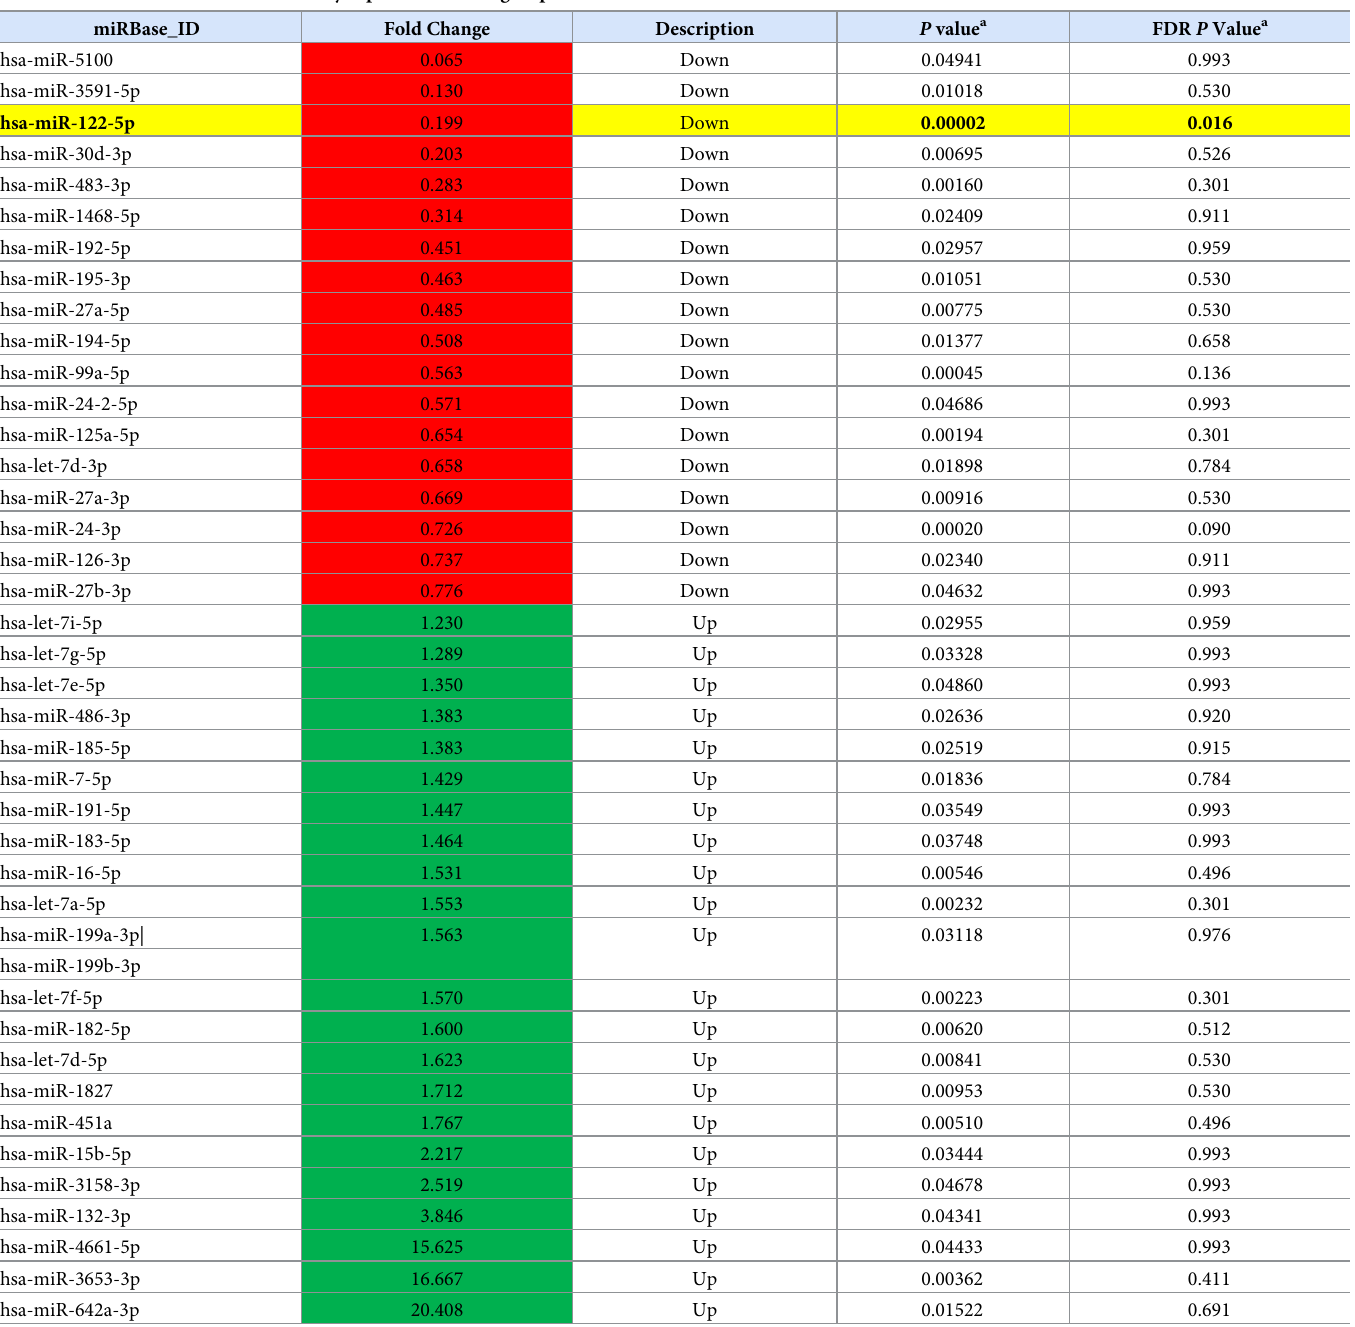
Table 4. Exosomal miRNAs differentially expressed in AAA group vs. controls.